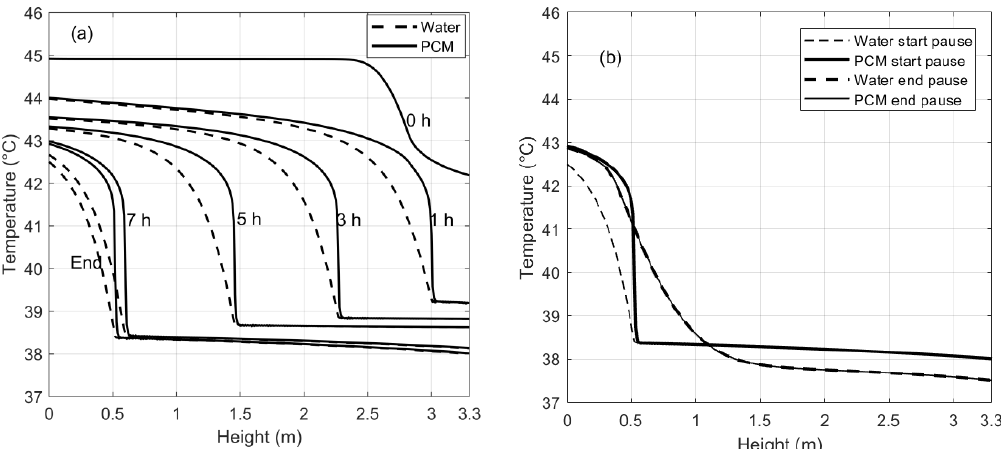
Figure 6. Evolution of the thermocline ( a ) during the discharge phase and ( b ) during the idle period after the discharge phase.